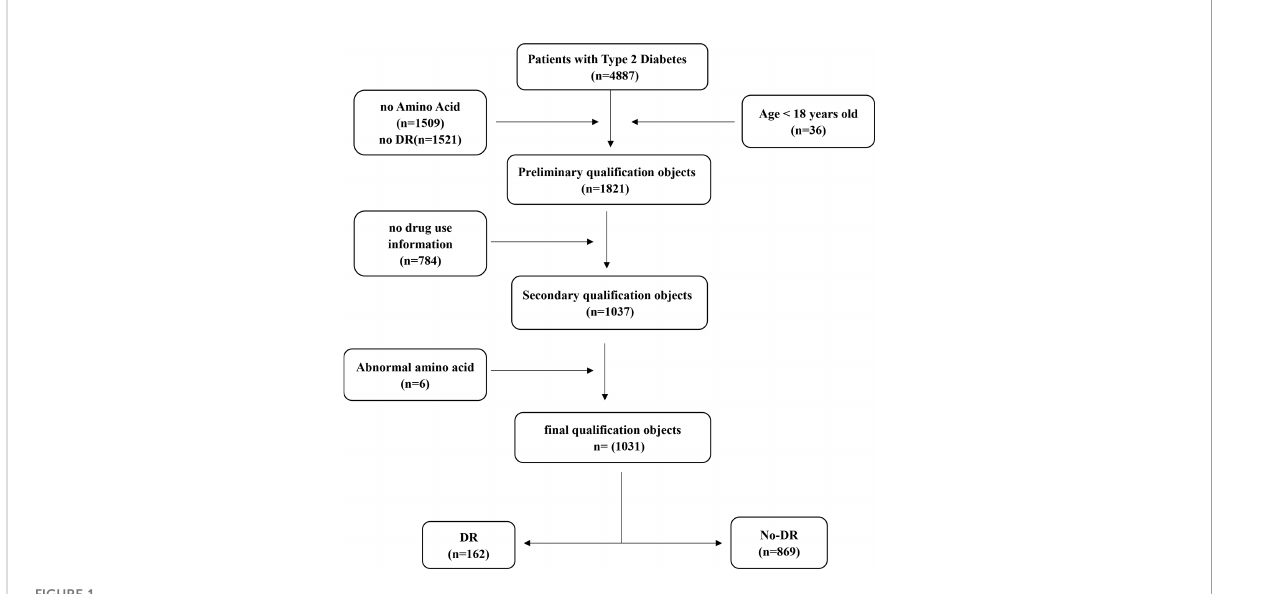
FIGURE 1 Schematic diagram of subject screening